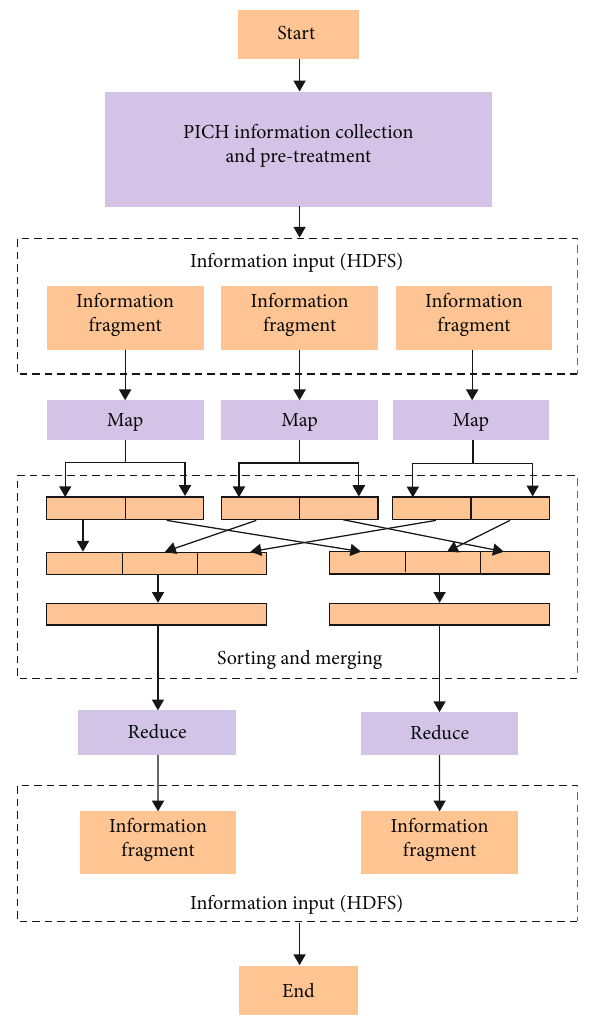
Figure 5: Map Reduce execution